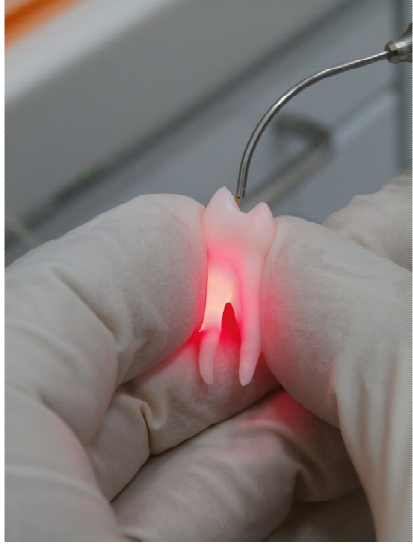
Figure 2. Diode irradiation of the buccal canal.